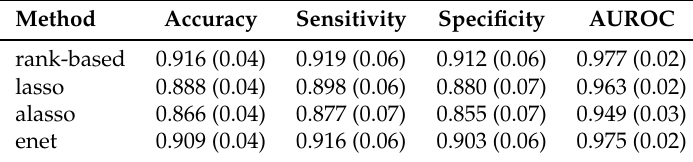
Table 4. Comparison of the performance among the four methods over 150 replications under simulation scenario 3. The values in parentheseses are the standard deviations.